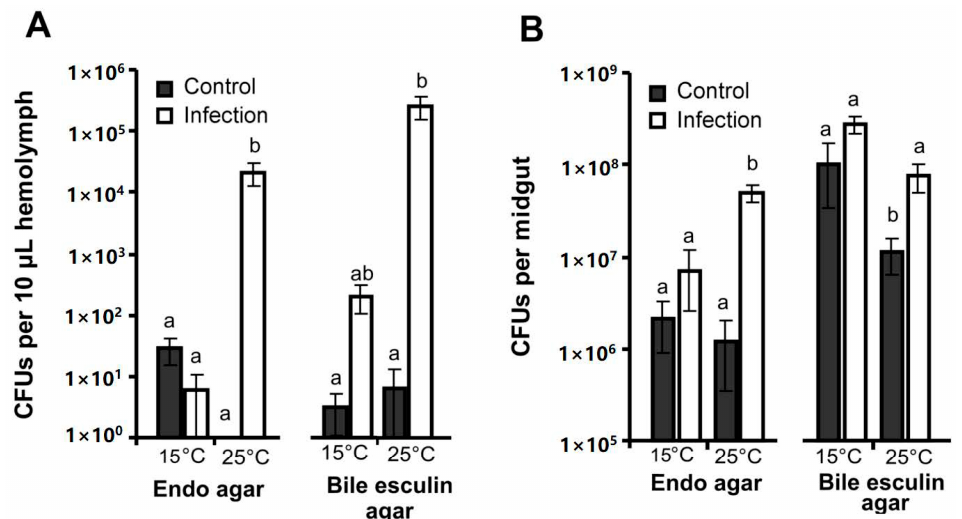
Figure 3. CFU counts in the hemolymph ( A ) and midgut ( B ) of wax moth larvae at 96 h post injection of С . militaris (2500 conidia per larva) with subsequent incubation at 15 °C and 25 °C. Selective media for enterobacteria (Endo agar) and enterococci (Bile esculin agar) was used. Different letters show significant differences within the specified media and tissue (Dunn’s test, p <